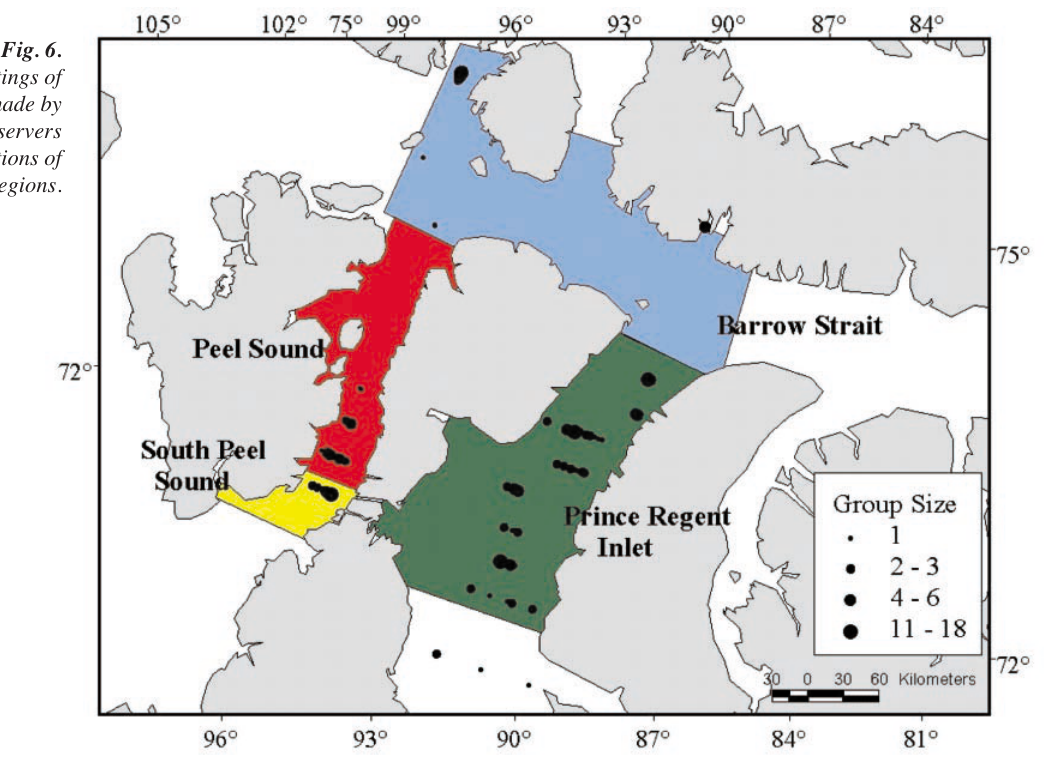
Fig. 6. Sightings of narwhals made by the front observers with definitions of